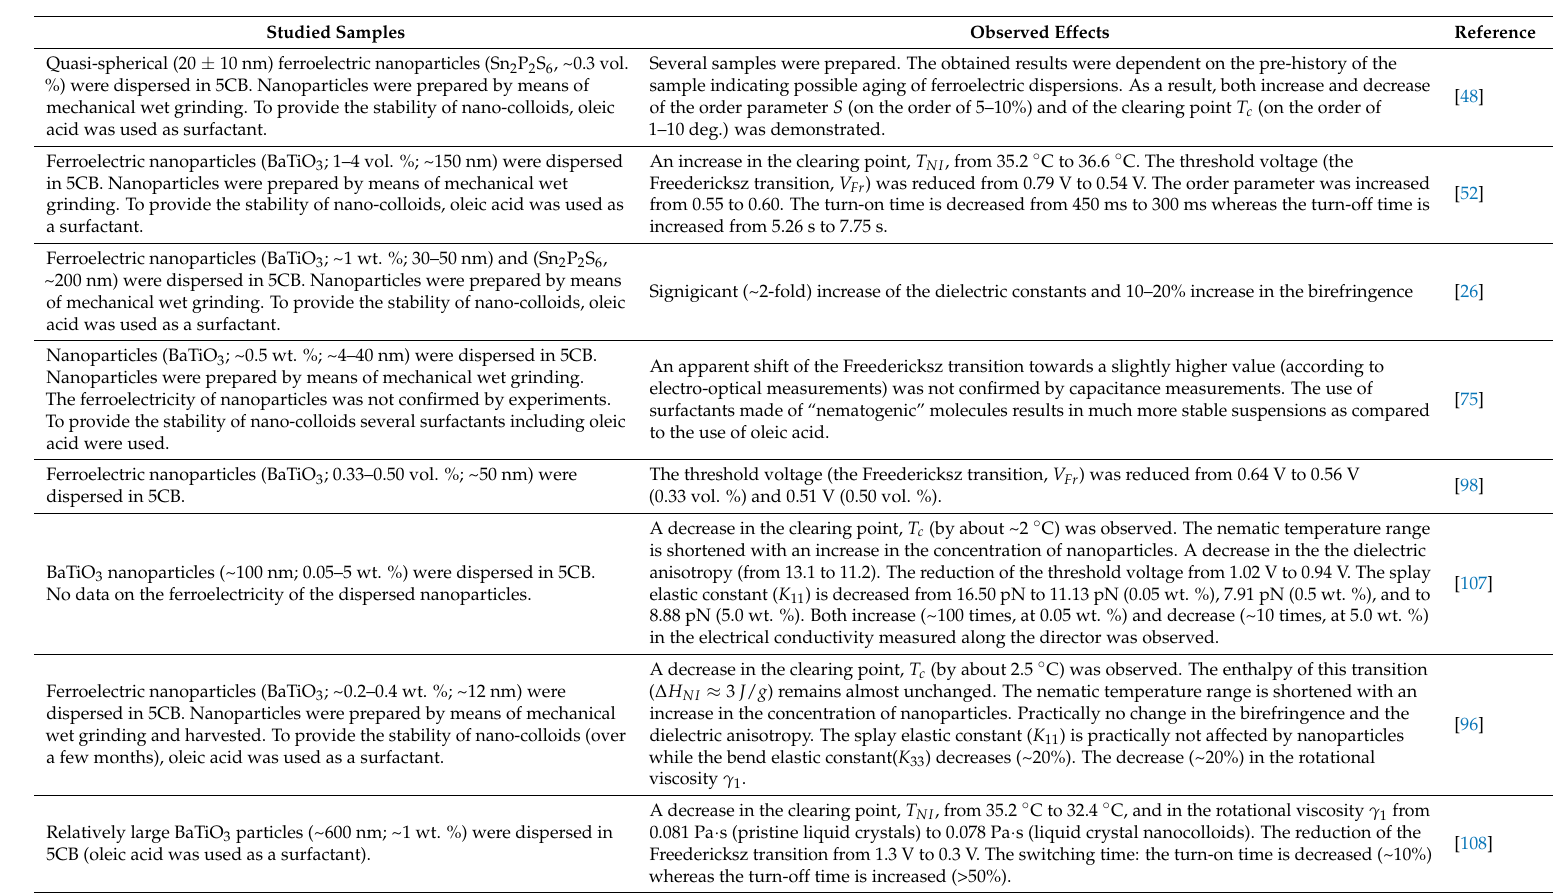
Table 1. Single component nematic liquid crystals (5CB) doped with ferroelectric